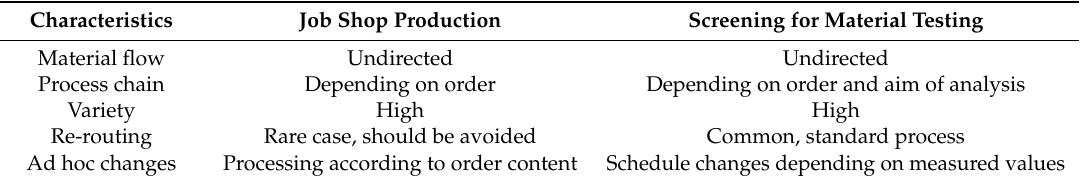
Table 1. Logistical control requirements